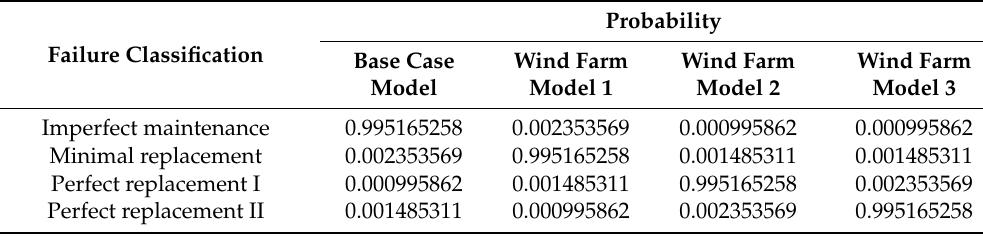
Table 3. Probabilities of failure classifications for di ff erent OWF models